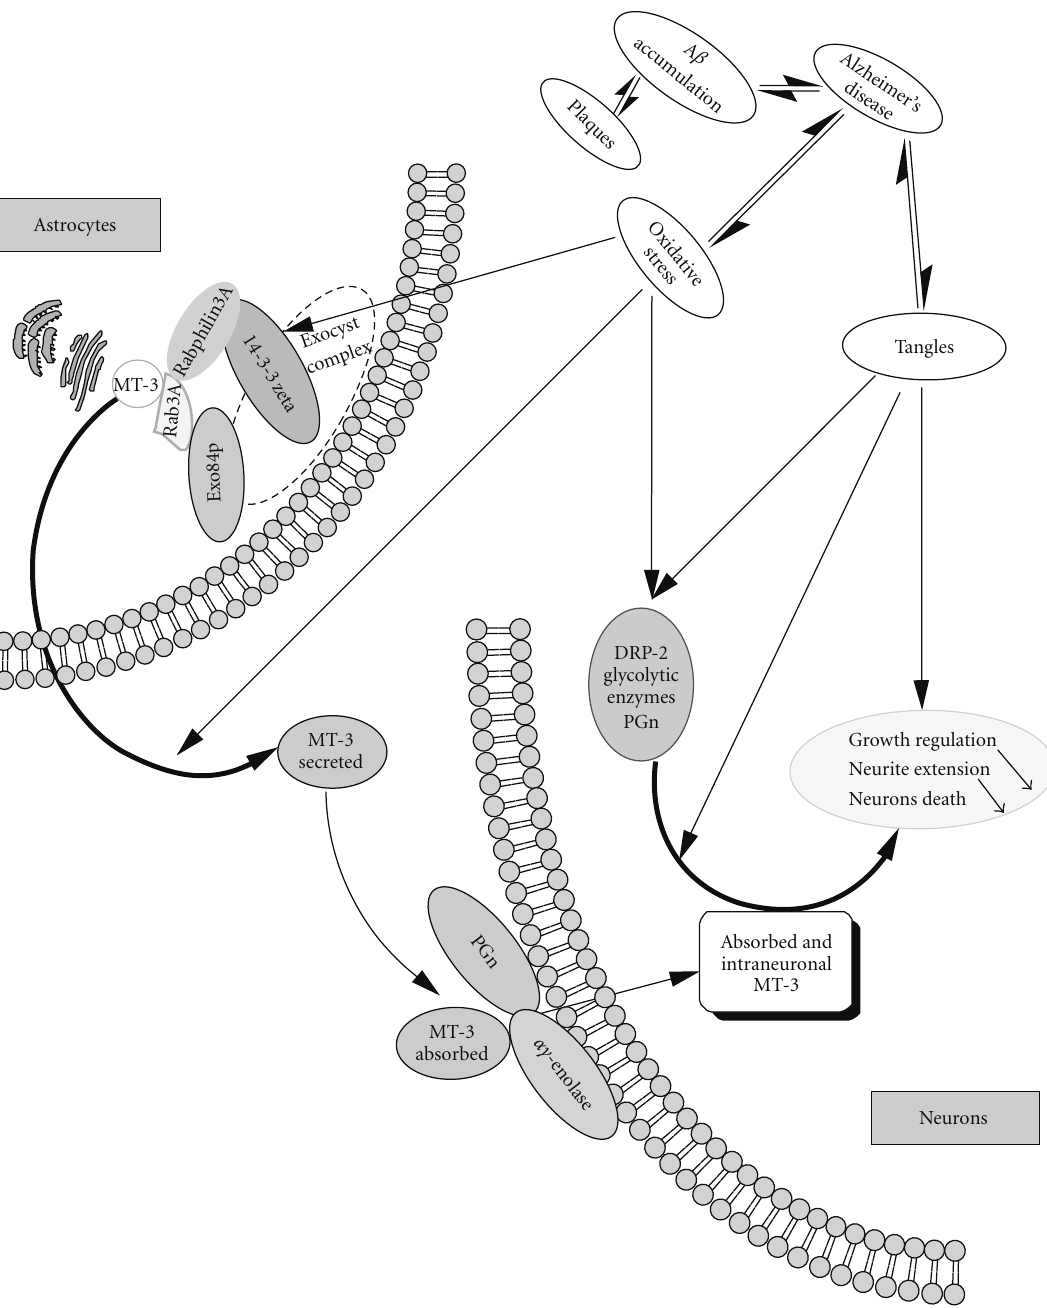
Figure 3: Schematic model of the interactions of MT-3 and its implication on the biological functions of MT-3. The hypothetical model describes the process of secretion of MT-3, from the astrocytes into the extracellular milieu, through its interaction with Rab3A, 14-3-3 zeta, Exo84p (Left panel). The uptake of MT-3 into the neurons and their growth regulation: uptake is facilitated through the interaction with the plasminogen (PGn) and enolase (either, αγ or γγ ). Once inside the neurons, MT-3 protects the neurons from the extension and the outgrowth through its interaction with DRP-2. In Alzheimer’s disease, oxidative stress alters several proteins involved in the interaction with MT-3, therefore potentially a ff ecting the pathway of secretion and/or the